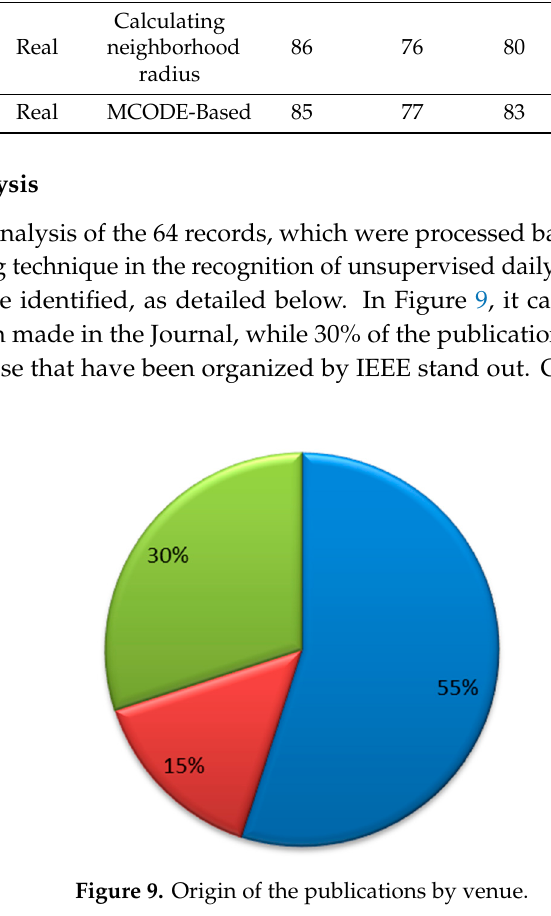
15 Figure 10. Analysis of the articles according to the year of publication. 0 510